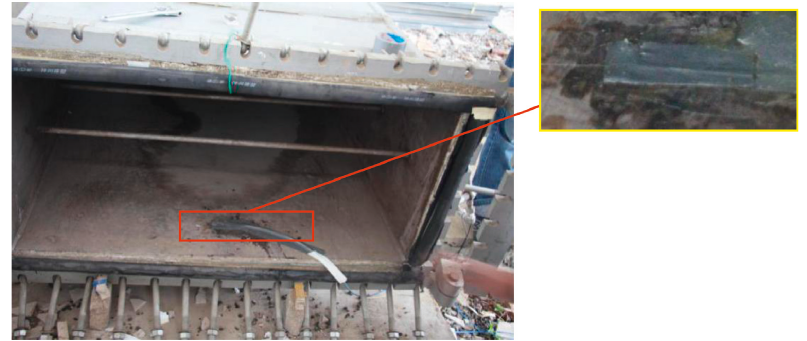
Figure 6: FBG sensor.